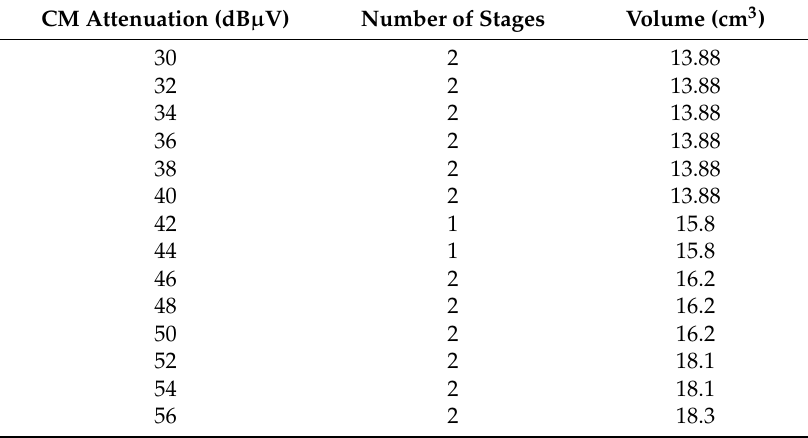
Volume and number of stages of the best design depending on the required CM attenuation–case study #1.